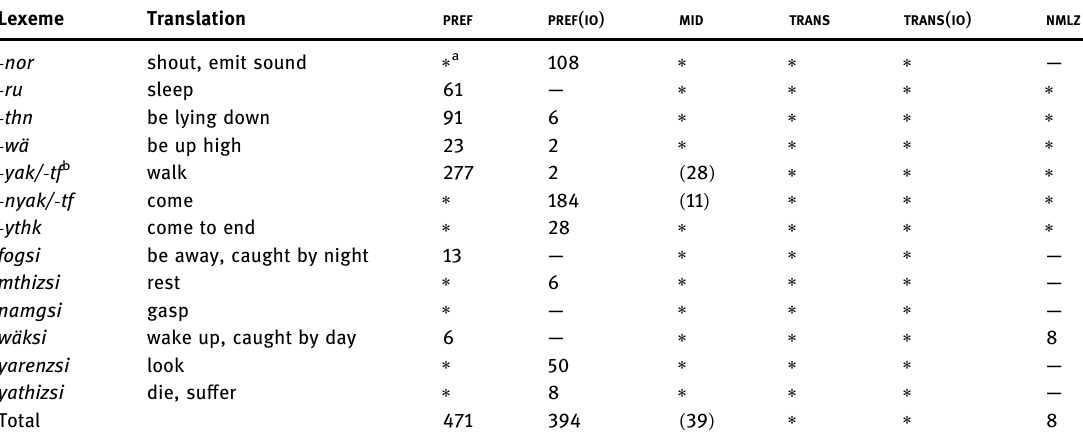
Table 6: Pre fi xing - only verbs